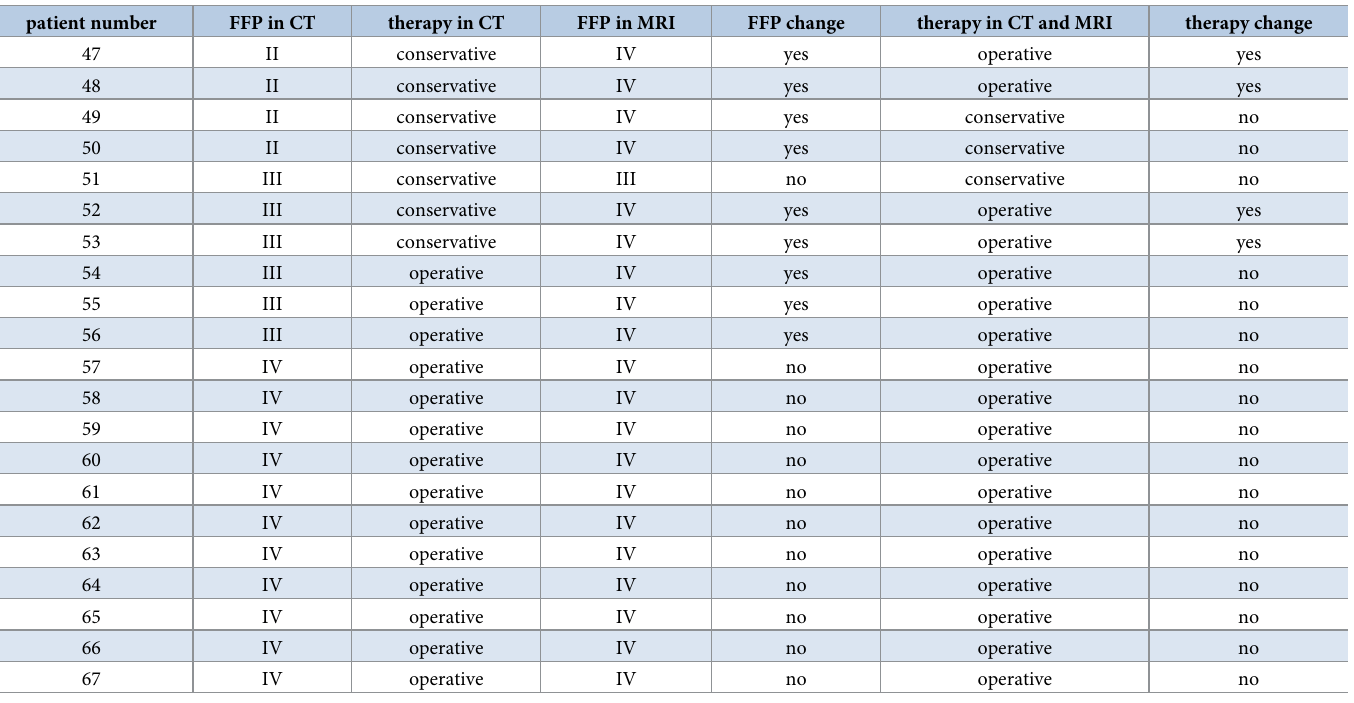
the correlation of bone density to fracture classification. vertebral body L5 as an indicator of bone density to the fracture classification could not show any correlation in the sense of a higher classification according to Rommens and Hofmann. Only 10% of the patients showed no clear bone density reduction based on the Hounsfield